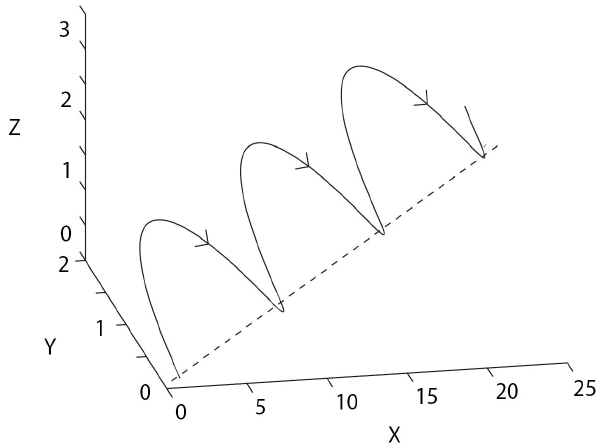
Fig. 1. A schematic of the cycloidal trajectory of a newly born ion, in the direction of the solar wind flow. The flow intersects the magnetic field (dotted line in x-y plane) and creates an electric field in the